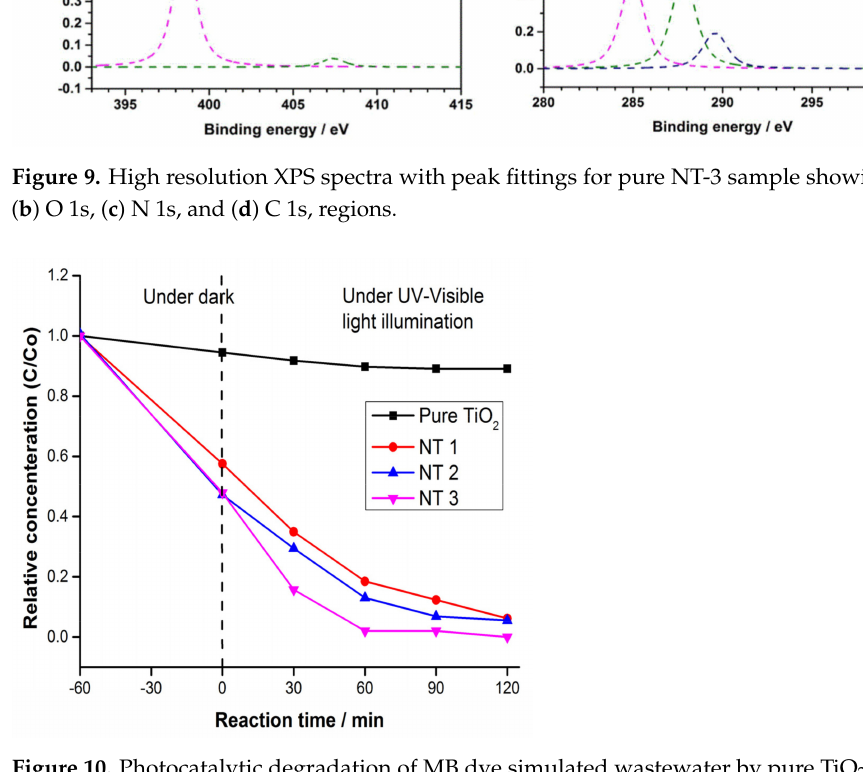
Figure 10. Photocatalytic degradation of MB dye simulated wastewater by pure TiO 2 , NT-1, NT-2 and NT-3